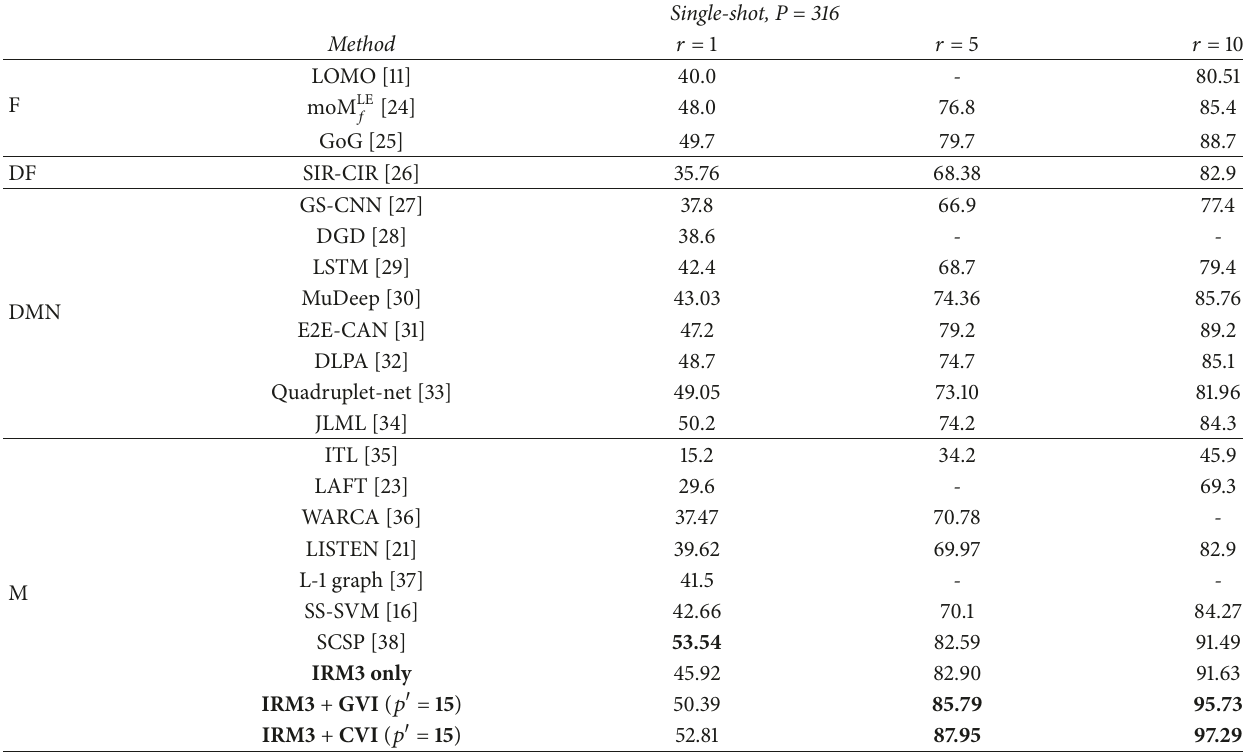
Table 1: Top matching comparison on